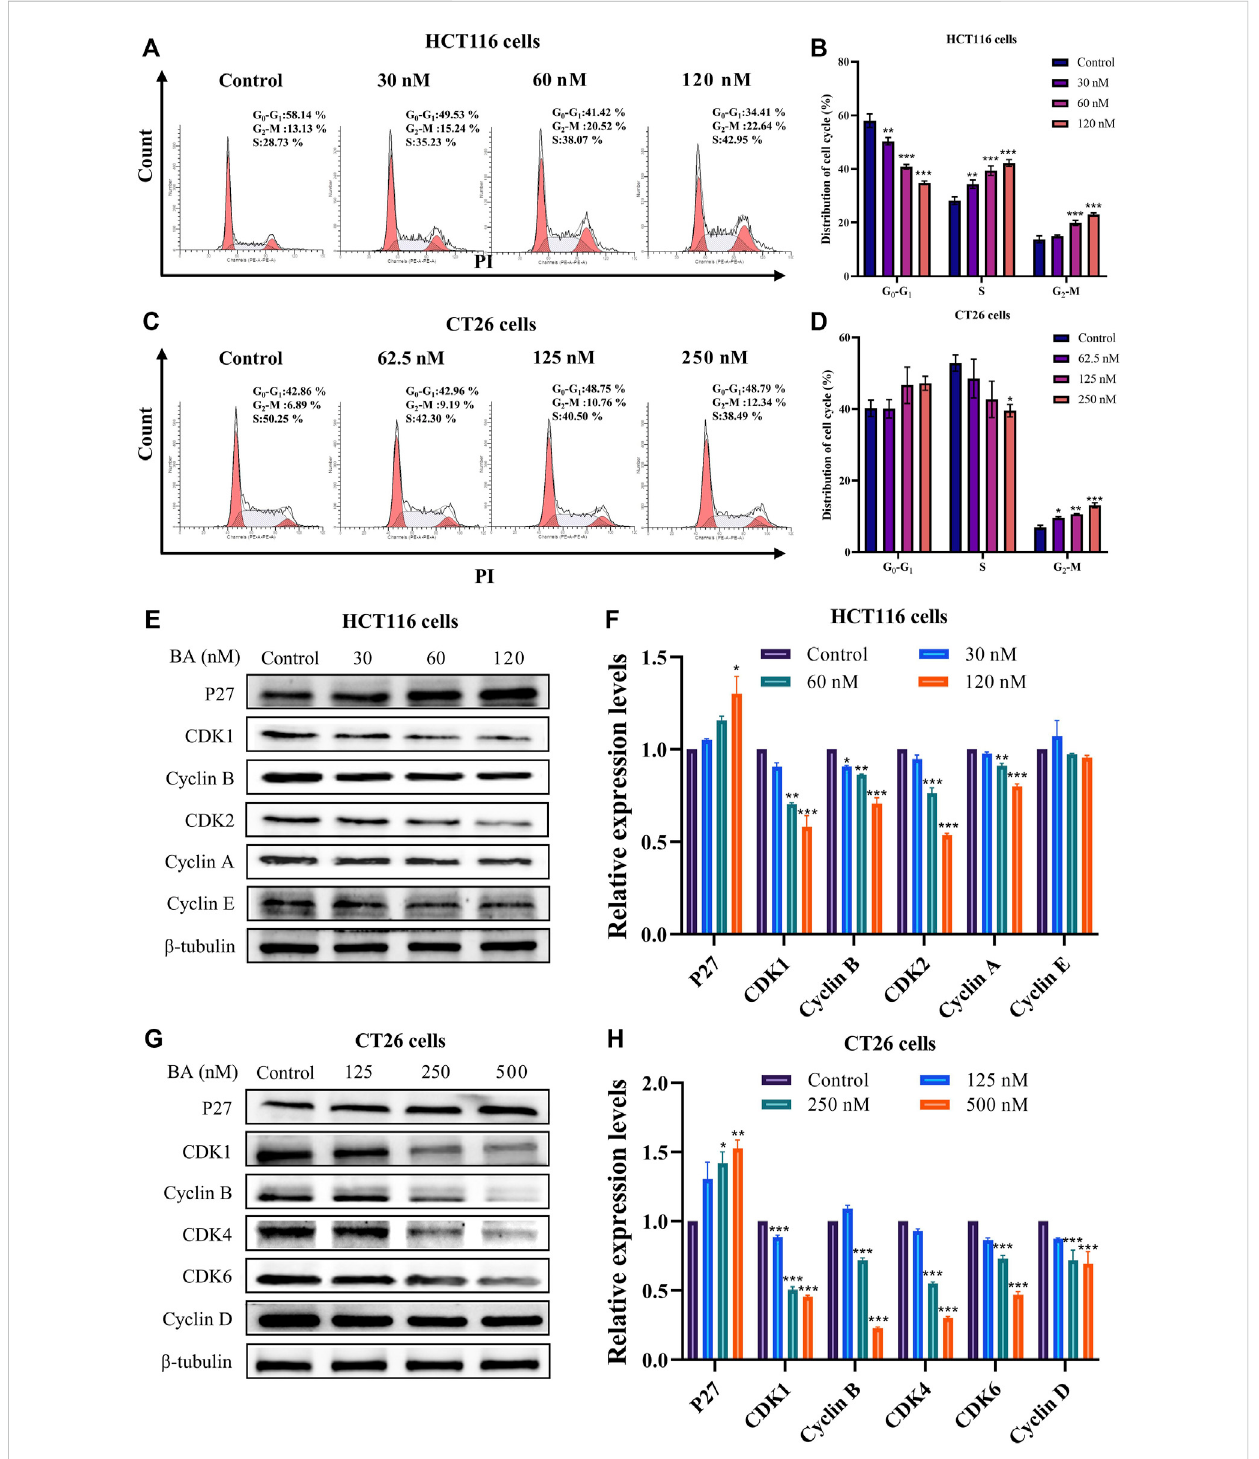
FIGURE 4 BA induced cycle arrest and modulated the expression of the cycle-related proteins in HCT116 and CT26 cells. (A – D) Cell cycle distribution of HCT116 (A) and CT26 (C) cells treated with BA. Statistical analysis of the percentage G0/G1, S and G2/M phases of HCT116 (B) and CT26 (D) cells treated with BA. (E – H) Western blot analysis for the expression of cycle related proteins in HCT116 (E) and CT26 (G) cells treated with BA. Statistical analysis of P27, CDK1, CDK2, Cyclin E, Cyclin B and Cyclin A levels in HCT116 cells (F) , and analysis of P27, CDK1, CDK4, CDK6, Cyclin B and Cyclin D levels in CT26 cells (H) . The protein levels were normalized to the control group. All data were representative of three independent experiments. * p < 0.05, ** p < 0.01, *** p < 0.001, compared to the control